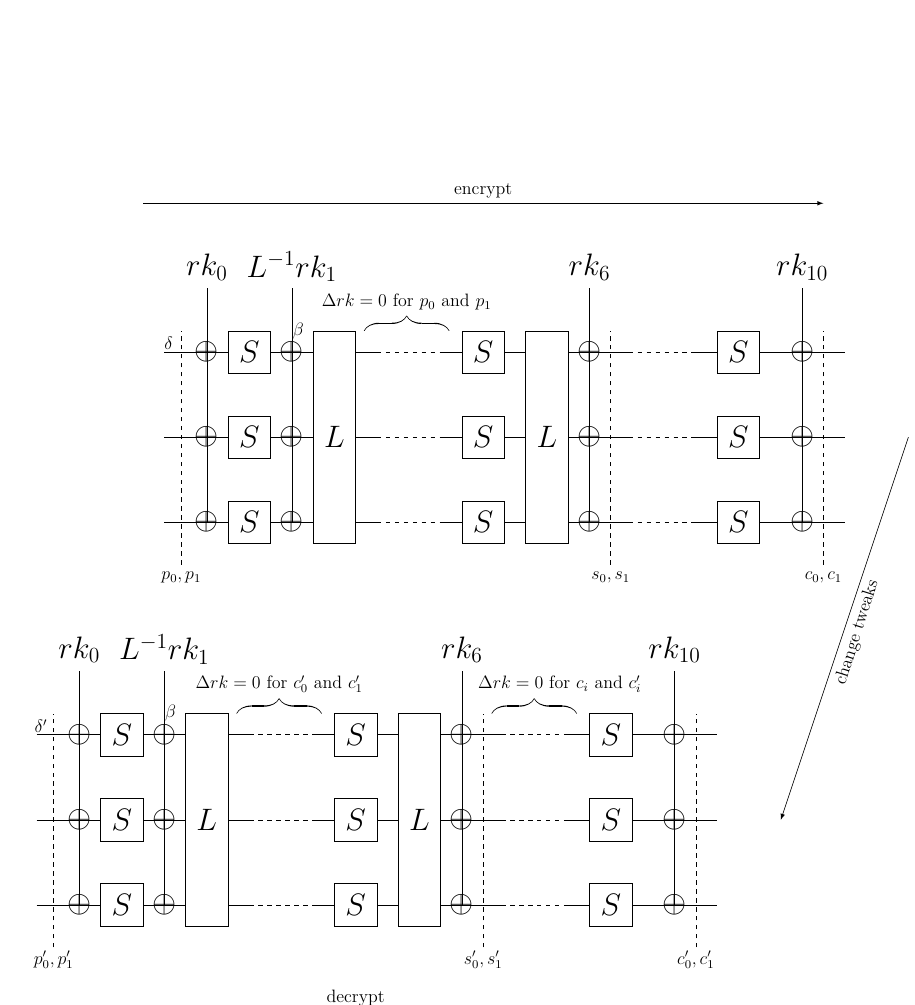
Figure 10: Boomerang key